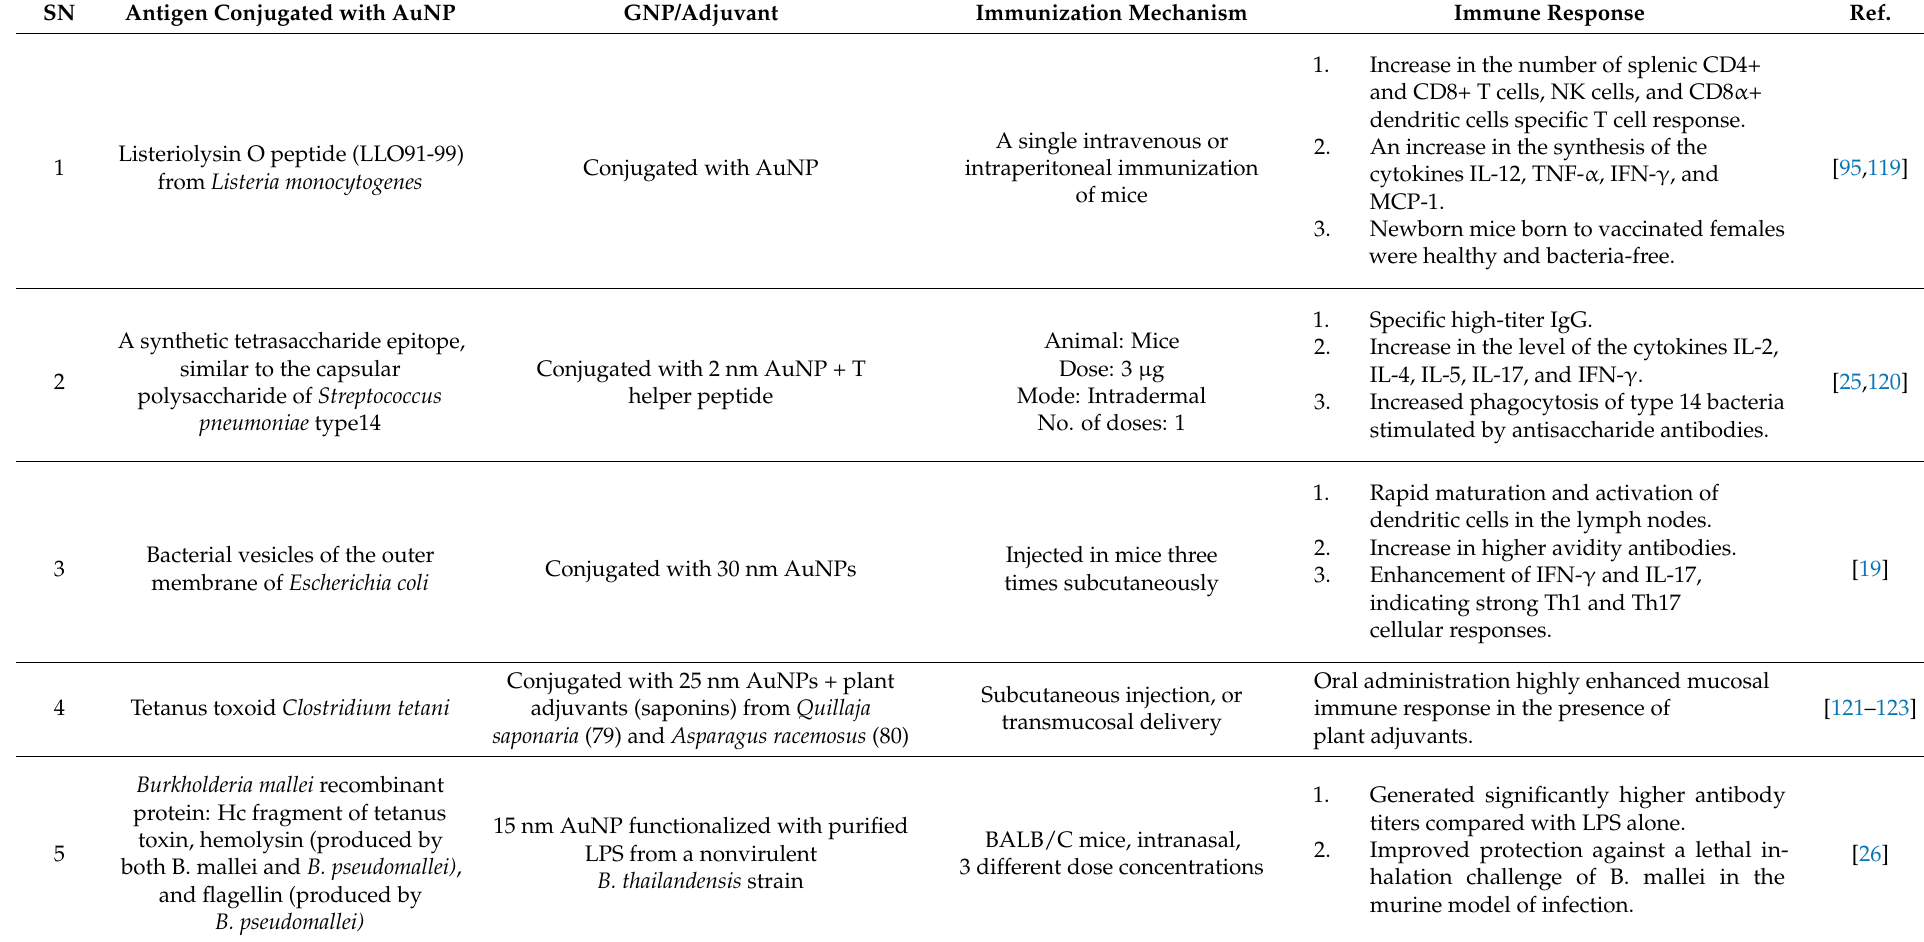
Table 2. Use of GNP based nanovaccine against bacterial